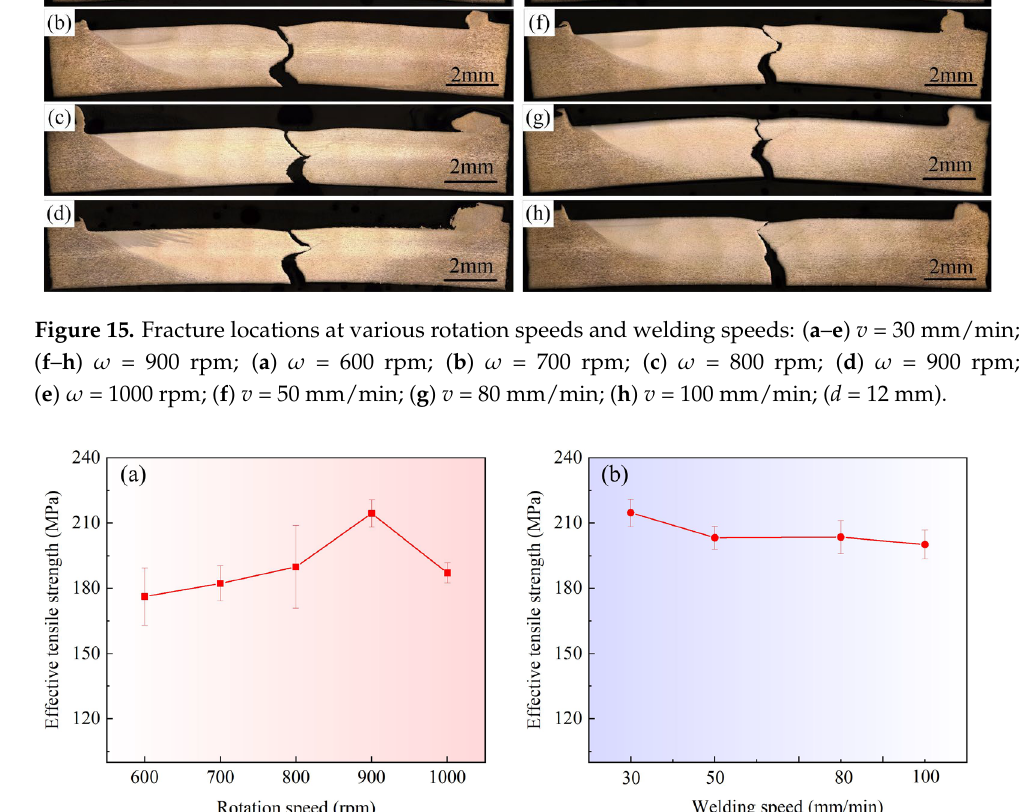
Figure 16. Relationship between the effective tensile strength and the welding parameters: ( a ) weld penetration to rotation speed; ( b ) weld penetration to welding speed; ( d = 12 mm).